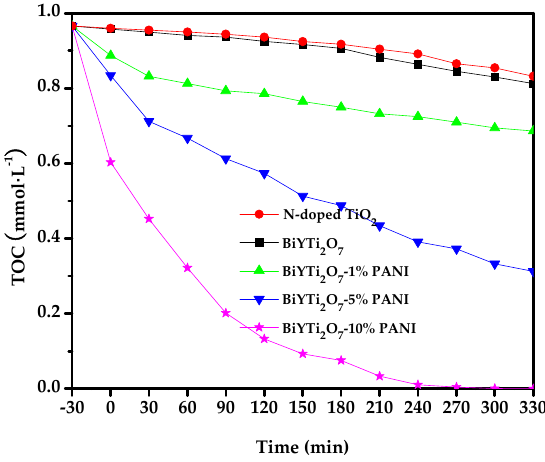
Figure 14. Disappearance of the total organic carbon (TOC) during the photocatalytic degradation of AG with different PANI-modified BiYTi 2 O 7 and N-doped TiO 2 as a catalyst under visible light irradiation.